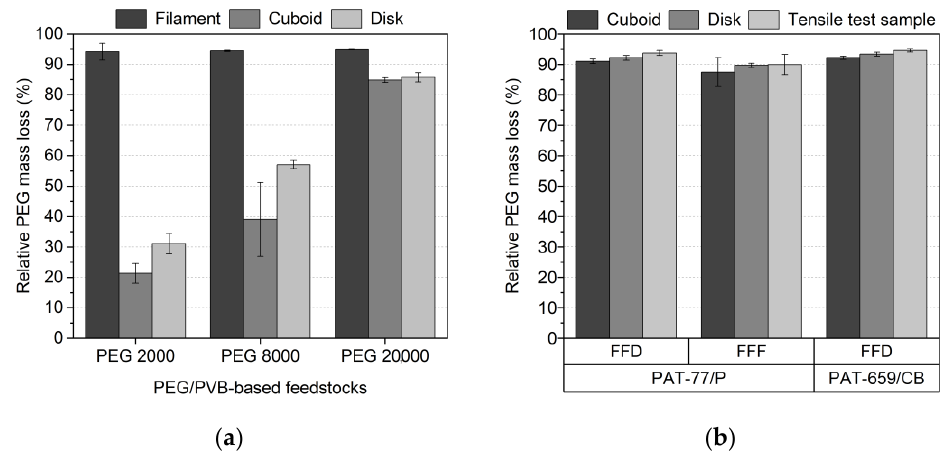
Figure 16. Relative PEG mass loss of water-soluble PEG-containing feedstocks after 24 h. ( a )